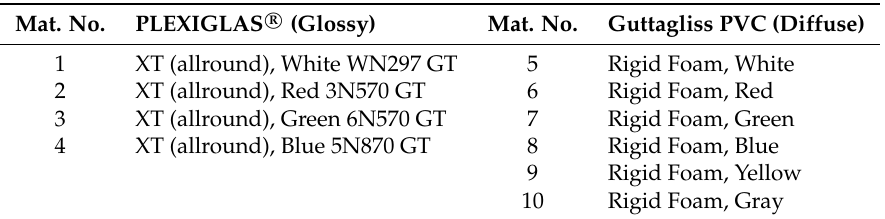
Table 1. Materials used for BRDF measurement. The PLEXIGLAS R (cid:13) provides more specular reflection, and the PVC rigid foam is rather diffuse. Mat. No. PLEXIGLAS R (cid:13) (Glossy) Mat. No. Guttagliss PVC (Diffuse) 1 XT (allround), White WN297 GT 5 Rigid Foam, White XT (allround), Red 3N570 GT Rigid Foam, Red XT (allround), Green 6N570 GT Rigid Foam, Green 8 Rigid Foam, Blue 9 Rigid Foam, Yellow 10 Rigid Foam,